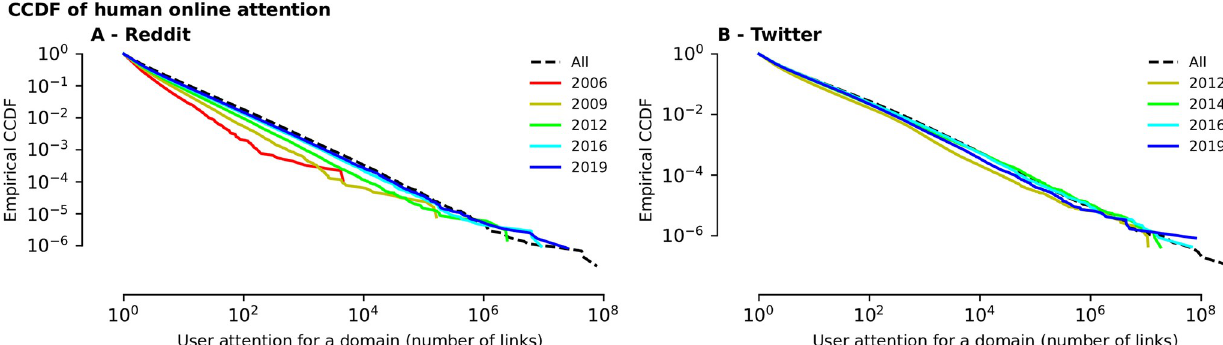
Fig 4. Cumulative attention in social media (Reddit and Twitter) follow a rich-get-richer distribution (i.e. long-tail), which get even more skewed over time. The log-log plot of the empirical Complementary Cumulative Distribution Function (CCDF) of the number of links associated with domains in both Reddit (A) and Twitter (B) appears almost linear—a sign of a long-tail distribution. Each solid line shows the distribution of links posted during a particular year, while the dashed line shows the distribution for the entire dataset.